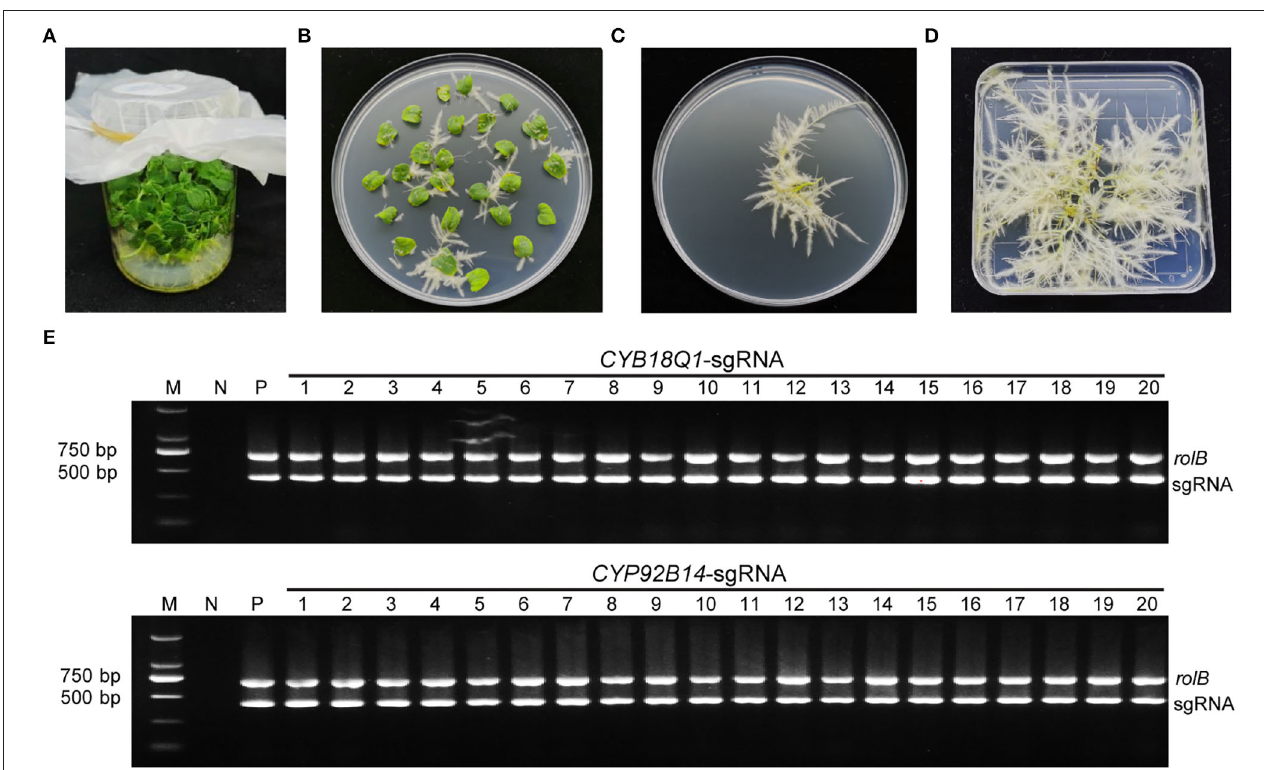
FIGURE 3 | Development and characterization of positive transgenic hairy roots. (A) Aseptic sesame seedlings cultivated on MS medium. (B) Transgenic hairy roots from cotyledon explants harboring the CRISPR/Cas9 vector. (C) Kanamycin-selected positive transgenic hairy roots. (D) Positive hairy roots were cultured for 2 weeks. (E) Characterization of positive transgenic hairy root lines. Each hairy root line genomic DNA was isolated and utilized as a template for PCR employing particular primers for the rolB genes along with the sgRNA expression cassette. The CYP81Q1-gR and CYP92B14-gR plasmids were utilized as a positive control (P), and genomic DNA from wild-type normal roots was utilized as negative control (N).